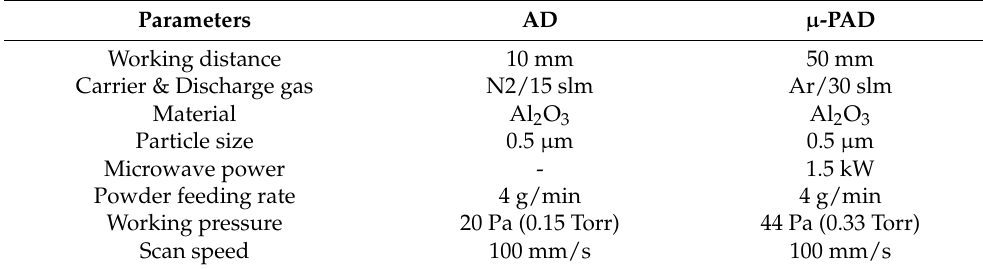
Table 1. Experimental parameters of AD and µ -PAD.